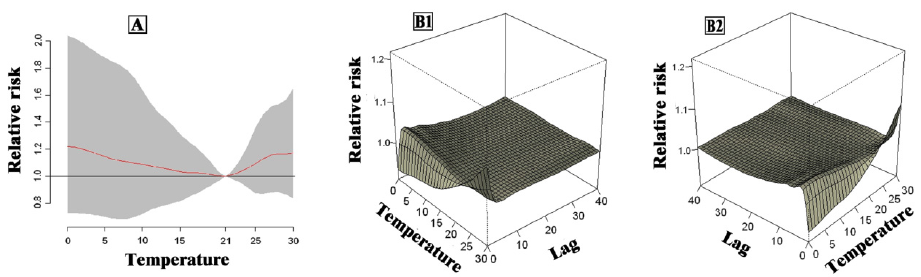
Figure 4. Overall ( A ) and three-dimensional ( B1 and B2 ) plot of RR in terms of temperature and lags